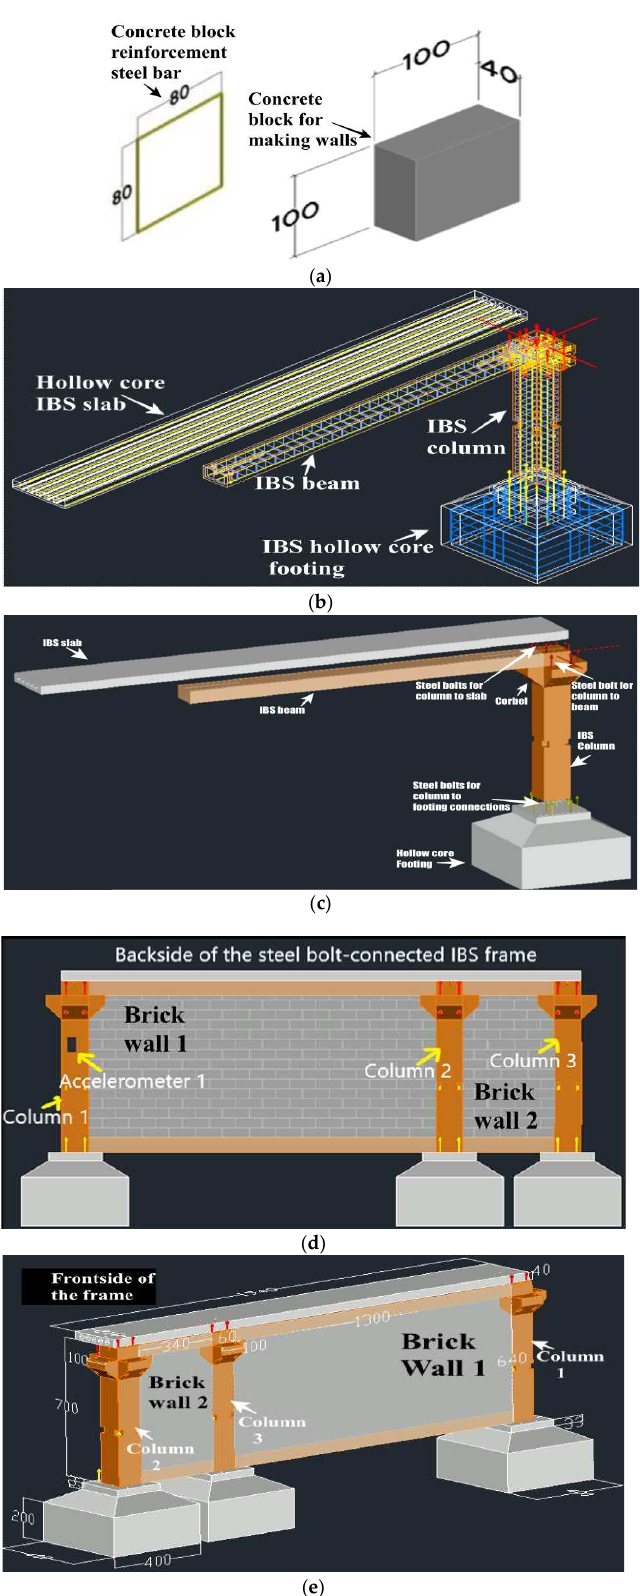
Figure 10. IBS frame: ( a ) details of brick; ( b ) AutoCAD reinforcement details; ( c ) frame components; ( d ) back of the frame; ( e ) front of the frame. Four beams with two different dimensions were connected to the footings and columns corbels: 1300 mm length × 100 mm breadth × 60 mm thickness; 340 mm length × 100 mm breadth × 60 mm thickness. The dimensions of the hollow-core slab are 1940 mm length × 220 mm breadth × 40 mm height, as shown in Figure 10d. There are two infill walls in the frame which were made up of concrete blocks as the bricks with the dimen- sion of 100 mm × 100 mm × 40 mm. The first infill wall from the left side in Figure 10d covered the area of 1300 mm × 580 mm with a thickness of 100 mm, and the total brick blocks are 183. The second infill wall covered the area of 340 mm × 580 mm with a thickness of 100 mm and 35 total blocks. 2.3. Procedure of Autodesk CFD Simulation for IBS Frame The process was started by importing the AutoCAD drawing of the testing tank with the modeling inside it. Figure 8 shows the reservoir on the right side filled with water as number 1, while the left side region where the modeling was placed is marked as number 2. The reservoirs were separated by a retaining wall with a gate cutout to al- low water to pass between. Regarding the material properties, concrete material was as- signed to the slabs, beams, columns, and hollow-core footings. Water was assigned to both reservoirs (1 and 2). Since Reservoir 1 was filled with water to flow to Reservoir 2, the height of fluid (HOF) initial condition was applied to Reservoir 1. The pressure con- dition was automatically applied at the liquid–air interface. Thus, there was no need to apply an additional pressure of boundary conditions in this model. Figure 11 presents the testing process.